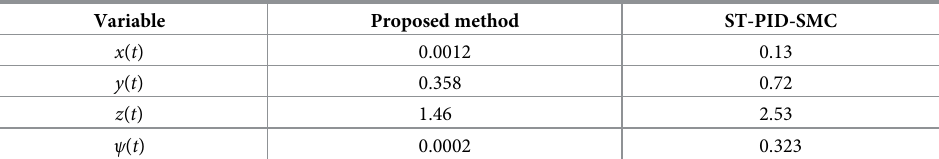
Table 5. ISE performance indexes of the scenario 2.